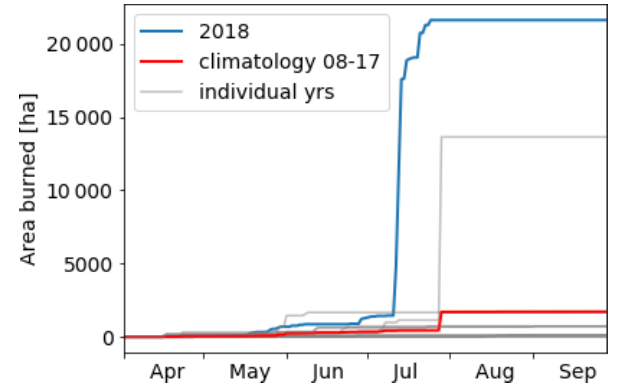
Figure 1. Burnt area in Sweden. Cumulative values for 2018, av- erage cumulative values (climatology) over 2008–2017 and the cu- mulative values for each individual year over the same time period (source: